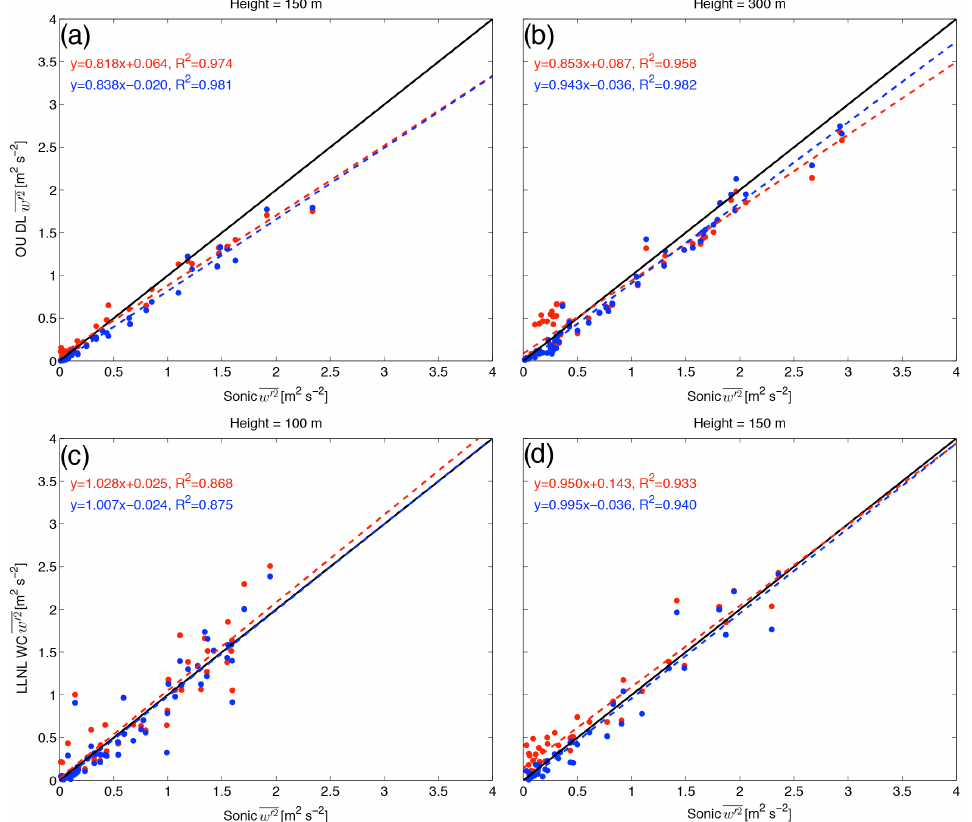
Figure 11. Comparison of w (cid:48) 2 computed from DL observations with those from the sonic anemometer observations at different heights. Heights were chosen to highlight differences in the quality of observations with height, and where high-quality sonic and lidar observations are available. Observations from the OU DL are shown in (a, b) , while LLNL WC measurements are shown in (c, d) . Red denotes w (cid:48) 2 ( 0 ) . Equations of the best fits are shown computed from the raw DL data (i.e. M 11 ( 0 ) ), while blue is for values wherein w (cid:48) 2 is taken as M ∗ 11 in the upper left of each plot, with R 2 being the coefficient of determination. Values of w (cid:48) 2 are averaged over 30min windows.